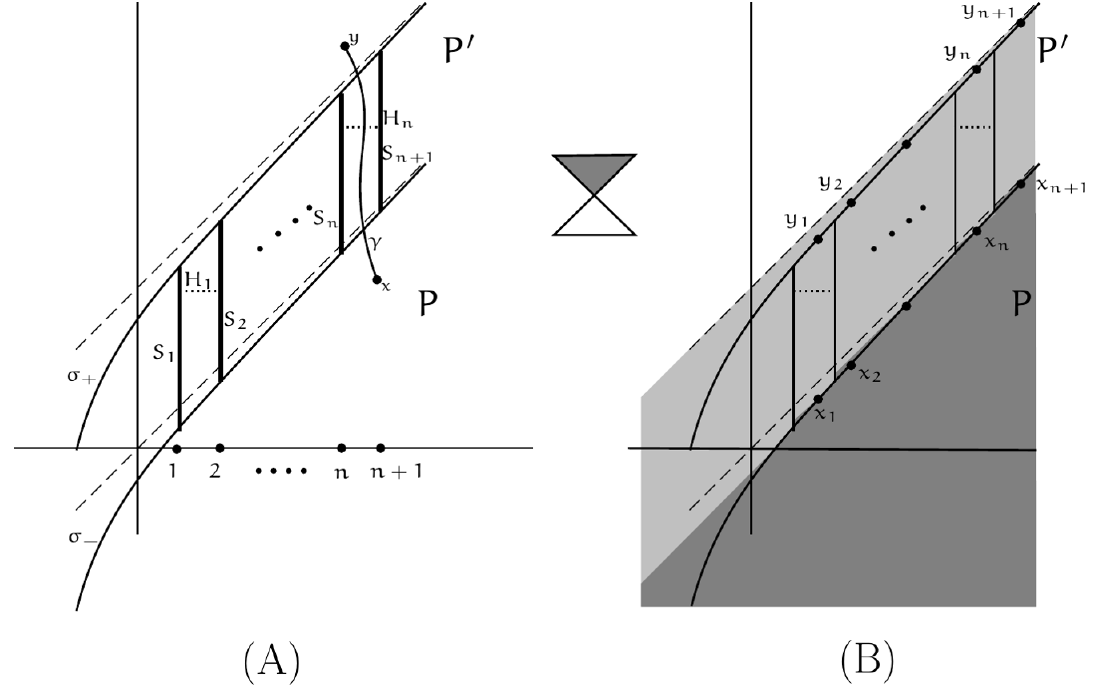
Figure 1 . The space M is constructed in the following way: consider in L 2 two timelike curves (cid:27) - and (cid:27) + approaching two parallel lightlike lines, as we can see in (A). M is obtained by removing from L 2 the segments S n obtained by joining vertically the points (cid:27) - ( n ) and (cid:27) + ( n ) . The universal cover V of M contains then a numerable family of copies of M glued along the segments H i coherently (see details on example 5.1 and